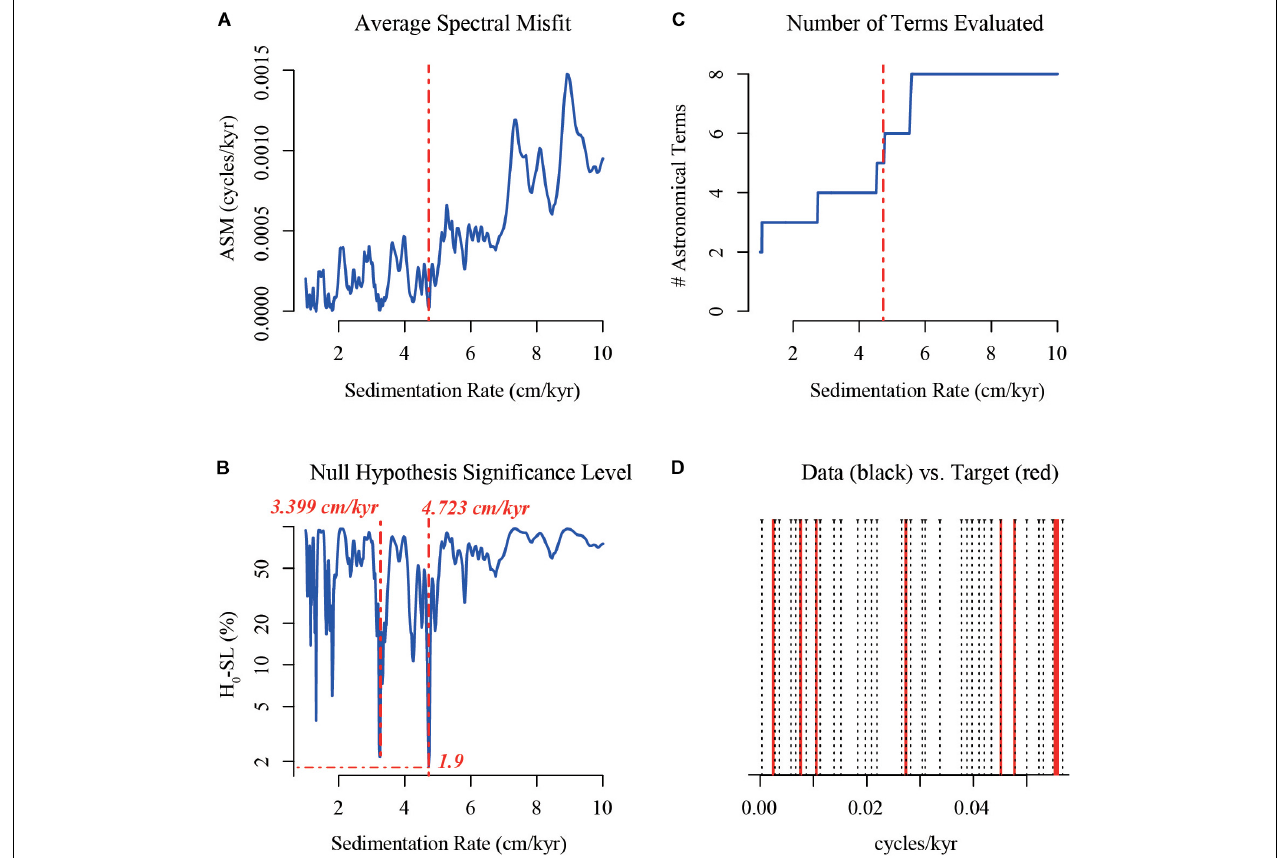
FIGURE 5 | ASM analysis of the DBG MS series, applied over a range of sedimentation rates from 1 to 10 cm/kyr by 0.0225 cm/kyr steps, using the La2004 astronomical target frequencies for 129.55–134.55 Ma ( Table 1 ). All harmonics in the MS series exceeding 85% significance level, a total of 42, are evaluated. The astronomical target used is based on the list in Table 1 , but has reduced the number of short eccentricity terms from four (1/132.129, 1/124.1212, 1/99.9024, 1/94.1609) to two (1/132.129, 1/95.25), which was found to yield a significantly lower H 0 (see Supplementary Material for ASM analysis with all 10 terms). (A) The ASM statistic between data and target spectrum. (B) The results of null hypothesis testing: H 0 is the probability of no target astronomical frequencies in the data. The optimal sedimentation rate occurs at the first joint lowest value ASM statistic and statistically significant H 0 minimum in the tested sedimentation rate range. (C) The number of astronomical terms used in the statistic; a total of 8 terms (frequencies) are included in the target (see above). (D) Comparison of significant spectral lines (dotted black lines) evaluated at the optimal sedimentation rate identified in (C) and the astronomical target lines (solid red lines). Vertical dash-dot red lines indicate solutions for optimal sedimentation